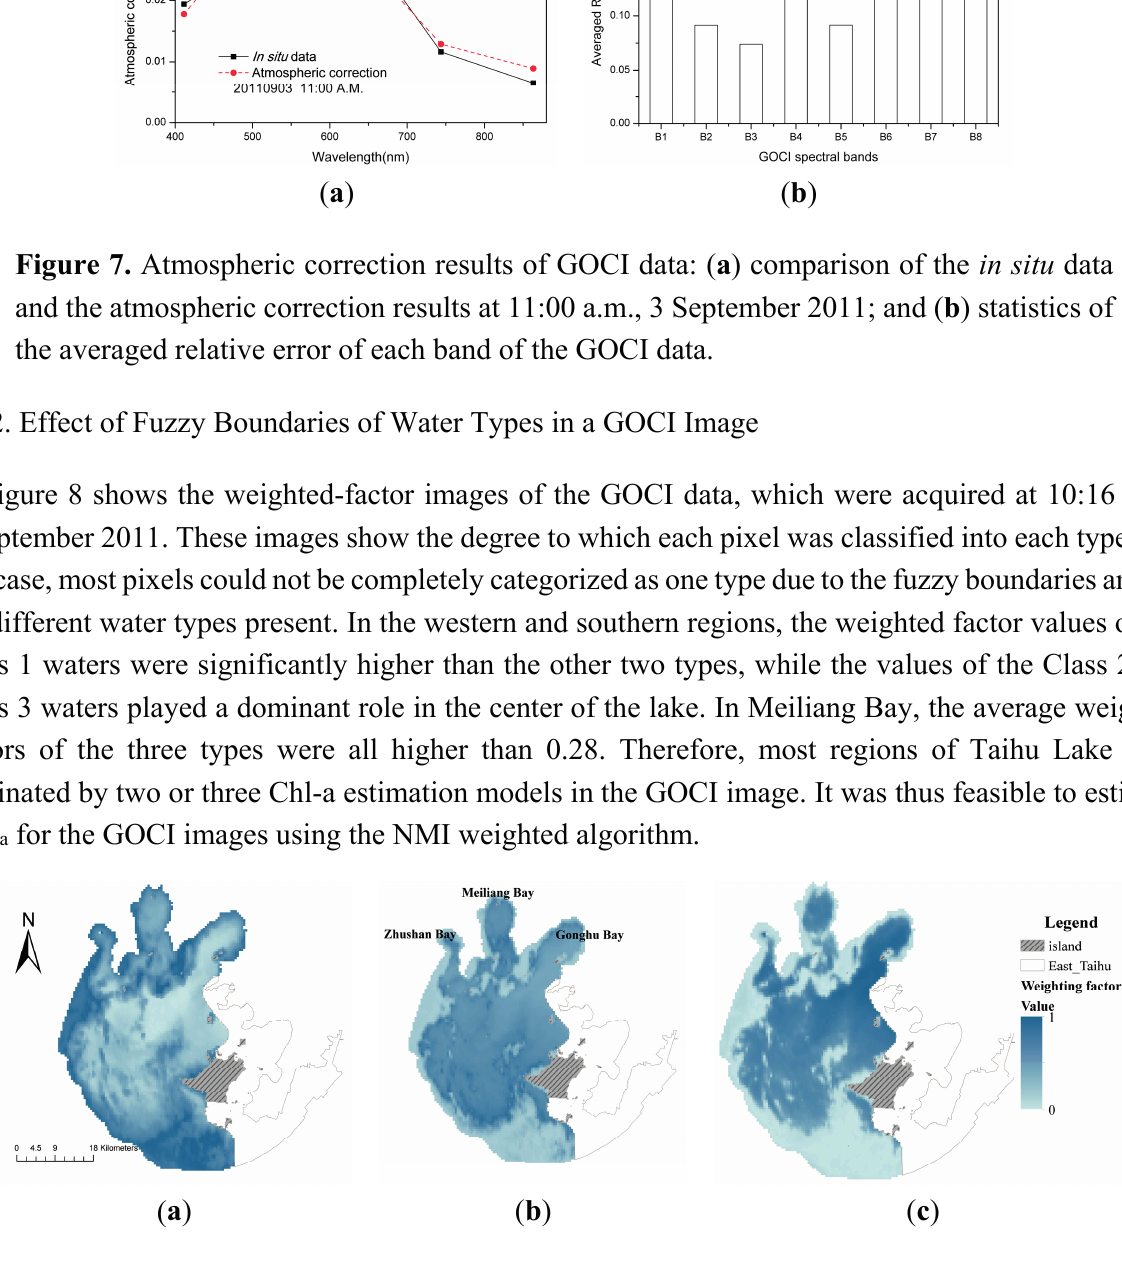
Figure 8. Weighting-factor images of each type for GOCI data (10:16 am, 3 September 2011): ( a ) Class 1; ( b ) Class 2; and ( c ) Class